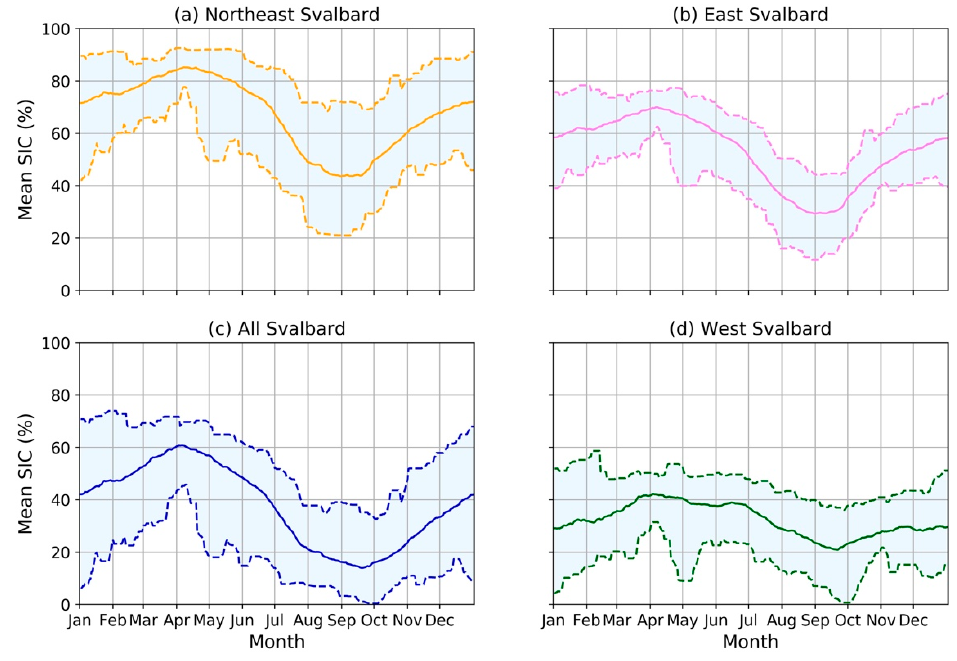
Figure 13. Sea ice concentration per DOY averaged over 19 years for subregions of the sea area around Svalbard as shown in Figure 4: ( a ) sea region northeast of Svalbard; ( b ) sea region east of Svalbard; ( c ) entire sea region around Svalbard; ( d ) sea region west of Svalbard. Solid lines indicate the average sea ice concentration (SIC), and the minimum and maximum SIC are shown by dashed lines. Table 4. Summary of the maximum correlation between the detrended time series of FSFD for four averaging areas and time-integrated sea ice concentration (TI-SIC) for four subareas of the sea around Svalbard. Asterisks indicate correlations that were statistically significant at the 95% level.